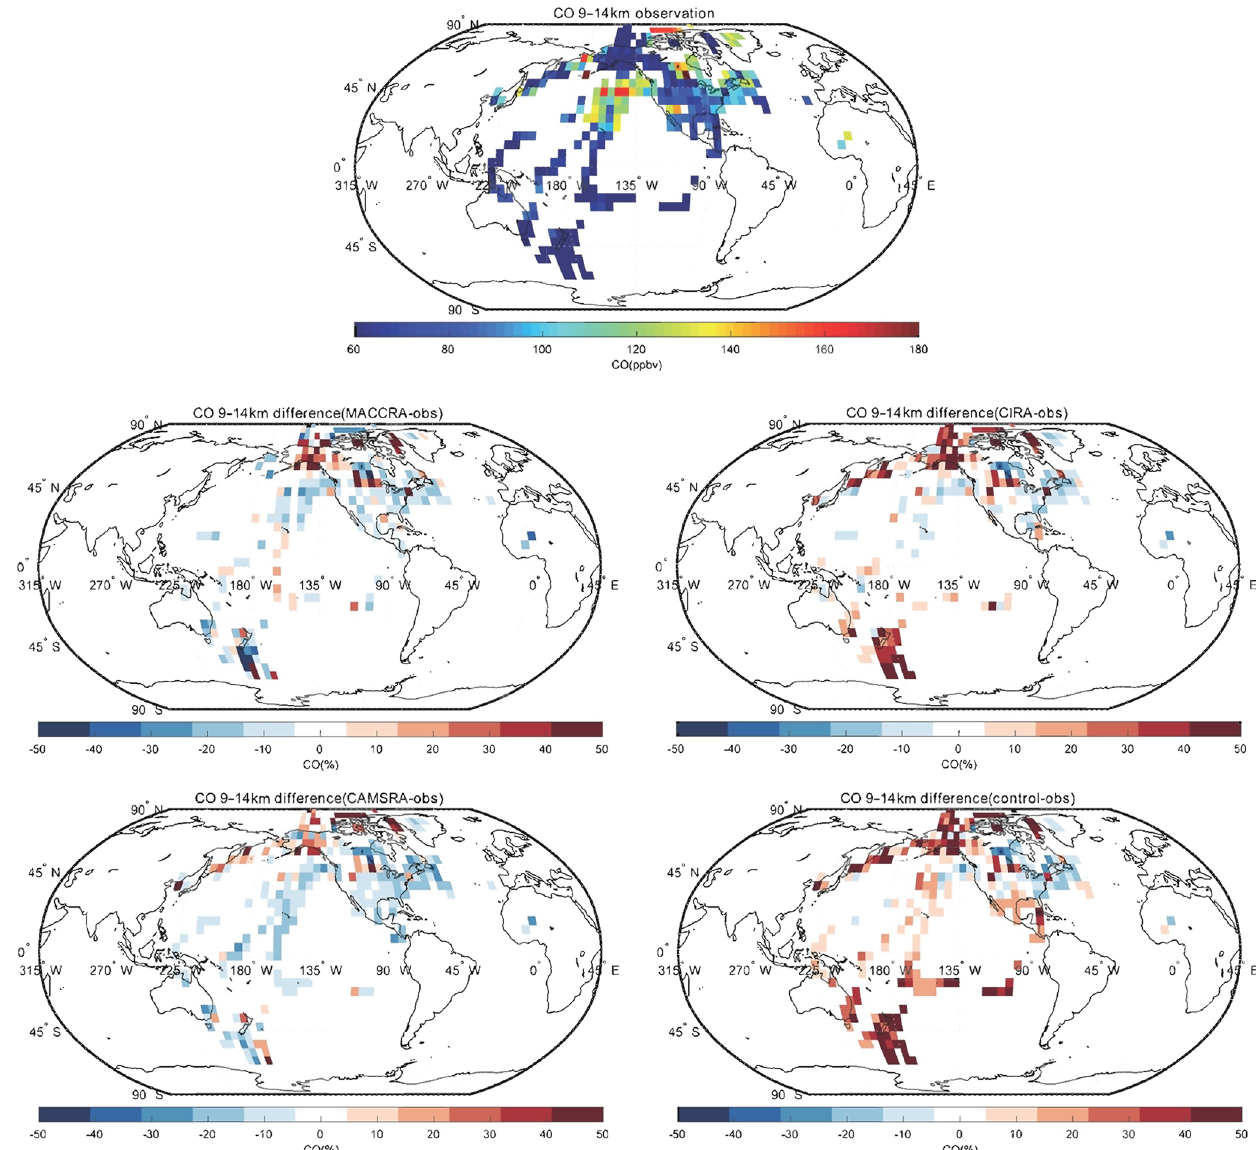
Figure 7. Same as Fig. 5, but for the altitude bin of